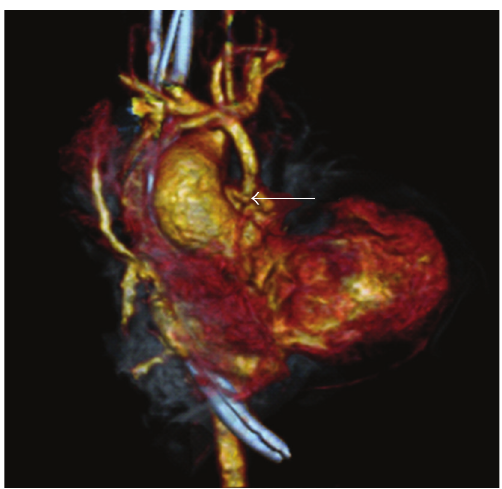
Figure 2: CT angiography with 3-dimensional reconstruction demonstrating a narrowing of the modified BT shunt at the point of anastamosis with the pulmonary